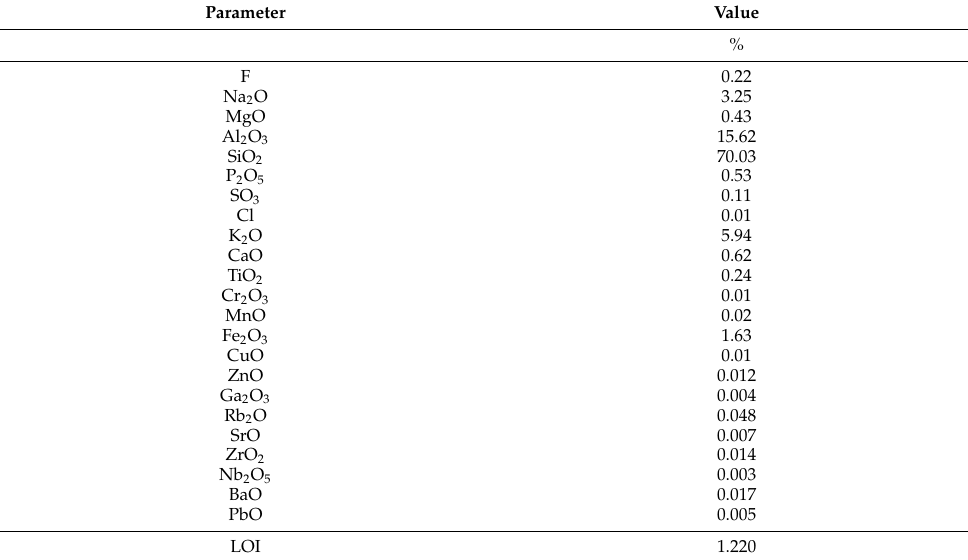
Figure 3. XRD of dried GS. Table 4. XRF analysis and Loss of Ignition (LOI) of GS